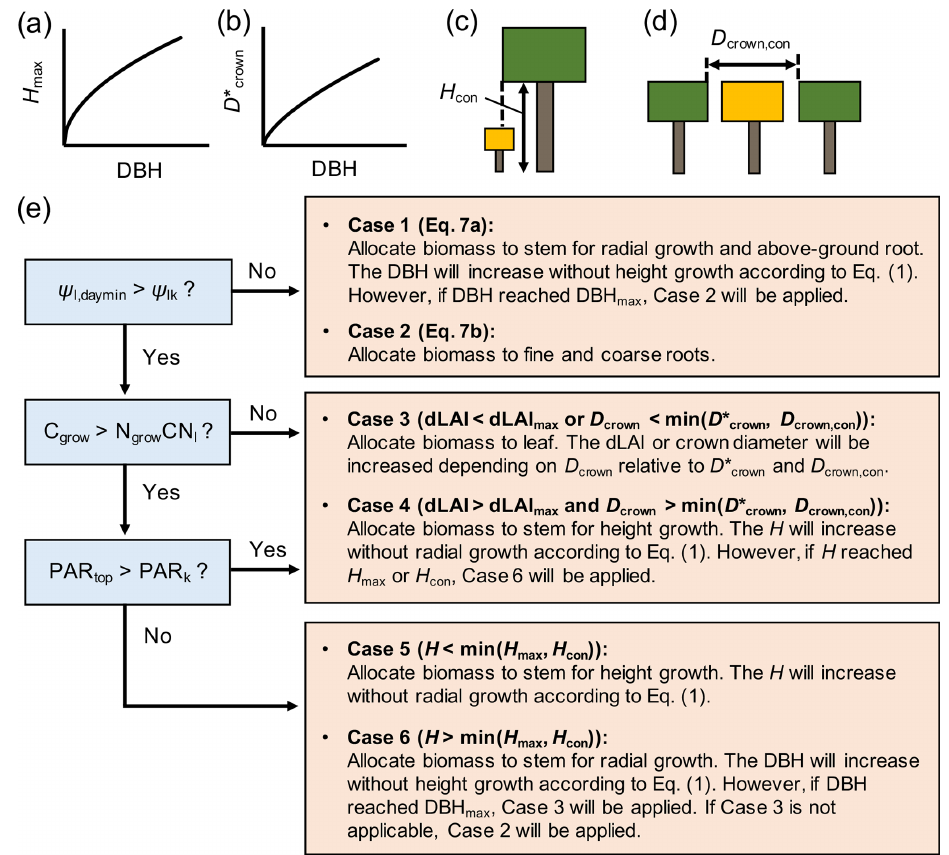
Figure 3. Schematics of (a, b) allometric and (c, d) physical constraints on tree height ( H max , H con ) and crown diameter ( D ∗ crown , D crown,con ), where the H con and D crown,con in panels (c) and (d) are for the tree with crown filled by yellow color and (e) the newly added biomass allocation scheme to SEIB-DGVM. See Note S1 for the derivation of allometric constraints from field